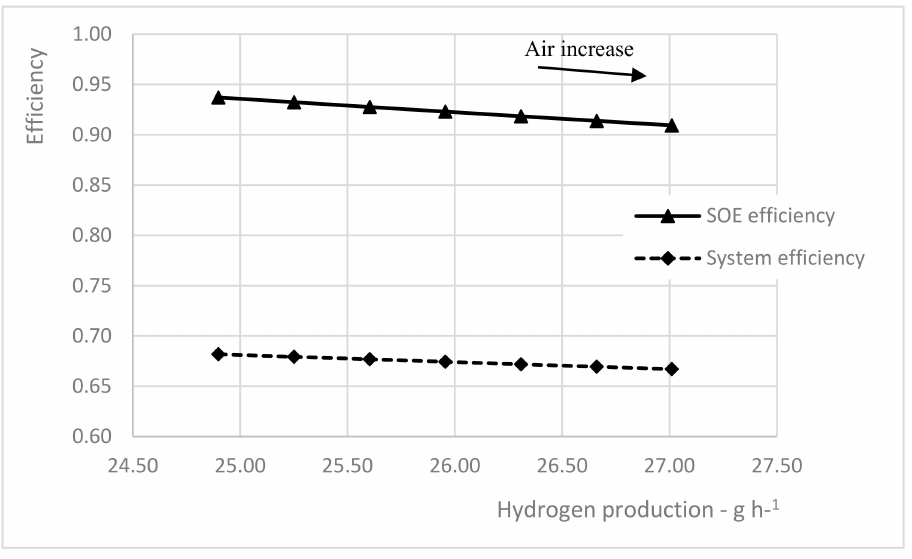
Figure 8. Efficiency vs. hydrogen production.